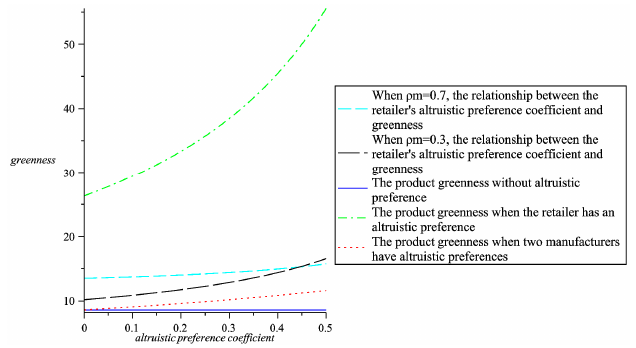
Figure 9. The relationship between product greenness and altruistic preference coefficients in four models